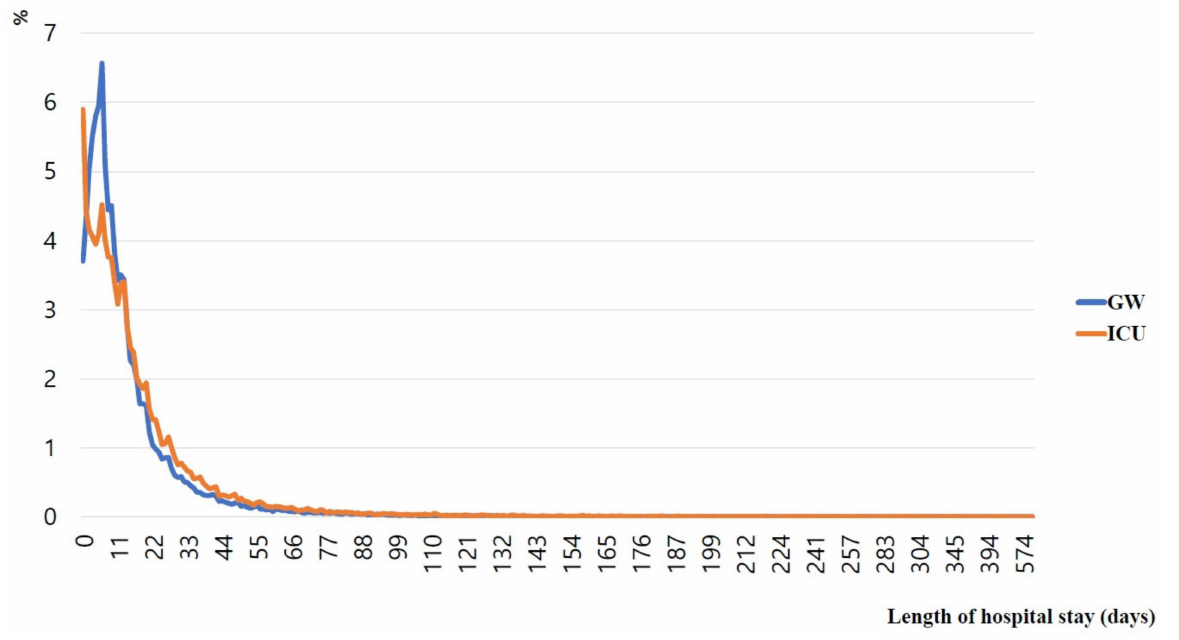
Figure 3. Proportion (%) of hospitalized (ICU or GW) patients who visited the emergency department from LTCHs by duration of hospitalization in days. GW, general ward; ICU, intensive care unit; LTCHs, long-term-care hospitals.